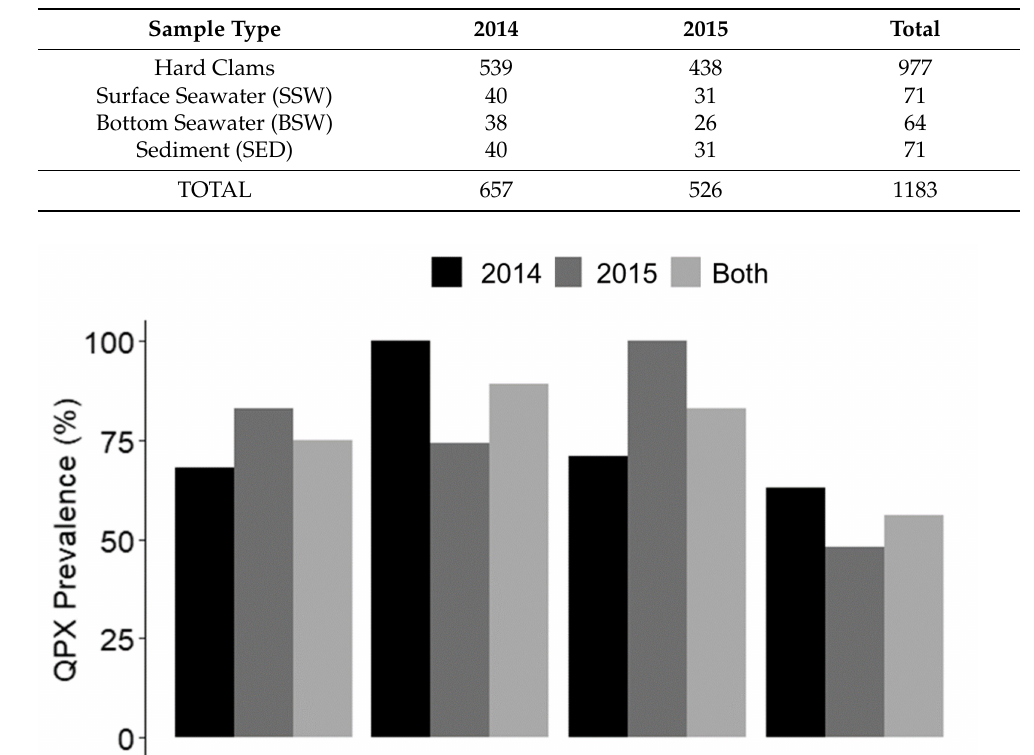
Table 1. Summary of samples collected during the two-year field survey.